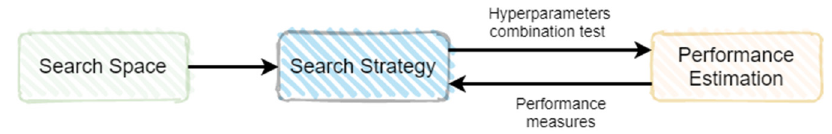
Figure 2. Basic concept of Neural Architecture Search (NAS).